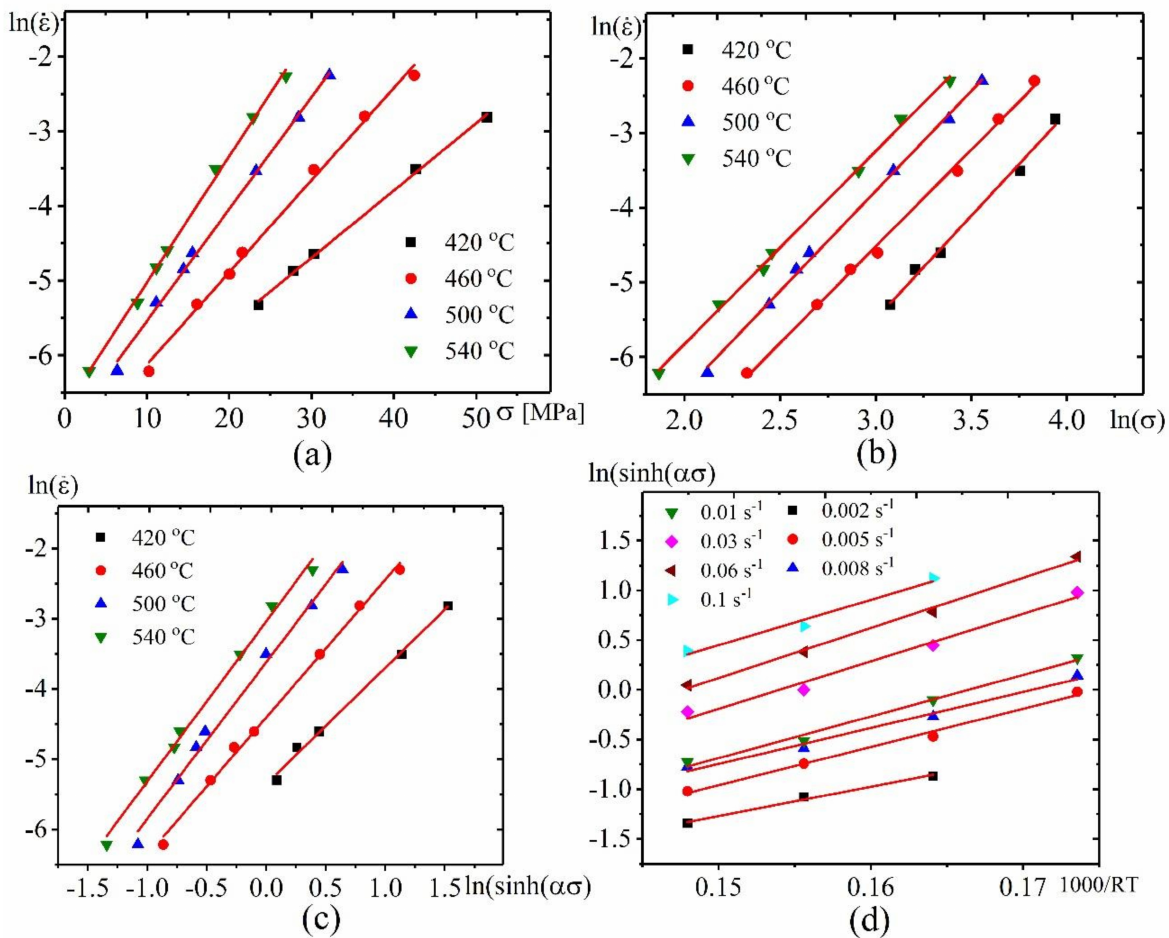
. . . ε − ln σ , ( b ) ln ε − σ , ( c ) ln ε − lnsinh ( ασ ) , and ( d ) lnsinh ( ασ ) − 1000